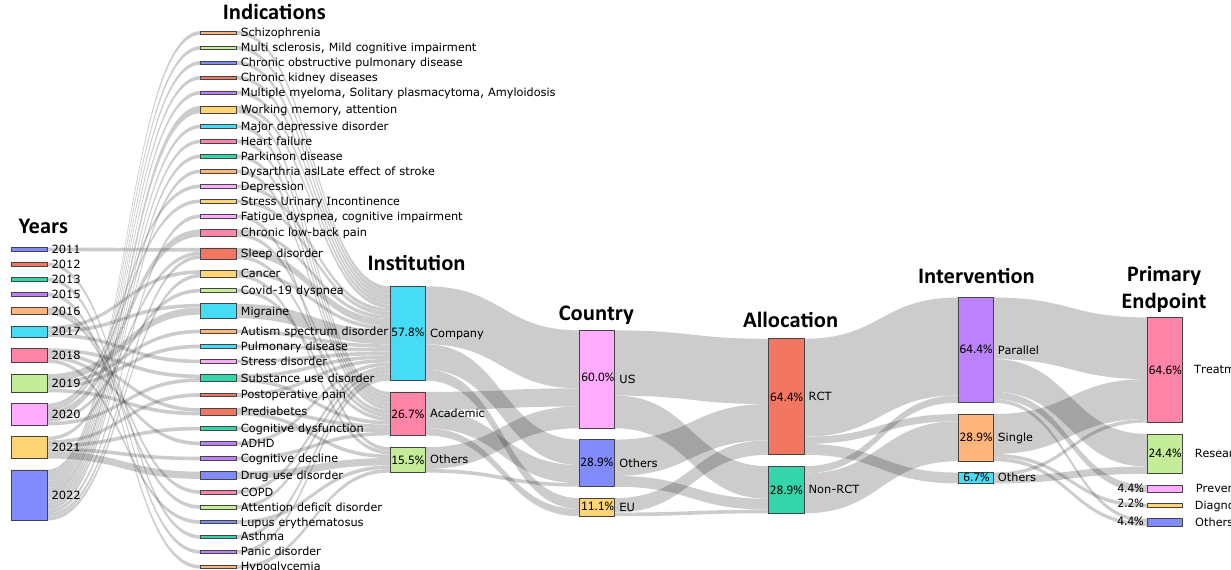
Fig. 1 Sankey diagram depicting digital therapeutics-related clinical research studies that have been assigned a National Clinical Trial (NCT) number. A Sankey diagram was utilized to analyze trends in indication, institution, country, trial type, intervention, and major outcomes. Between 2010 and 2022, a total of 31 clinical trials related to digital therapeutics were identi fi ed on the ClinicalTrials.gov website using the keyword “ Digital therapeutics ” . The clinical trials were conducted by a variety of institutions, including pharmaceutical companies, hospitals, research institutes, medical consortia, universities, and corporations. These trials were carried out in multiple countries, including the United States, Europe, Switzerland, Finland, South Korea, Italy, Brazil, Malaysia, Singapore, Canada, Israel, and Poland. The clinical trials employed interventions such as parallel, single, crossover, and factorial designs, with primary objectives that included treatment, research, prevention, diagnosis, supportive care, and basic